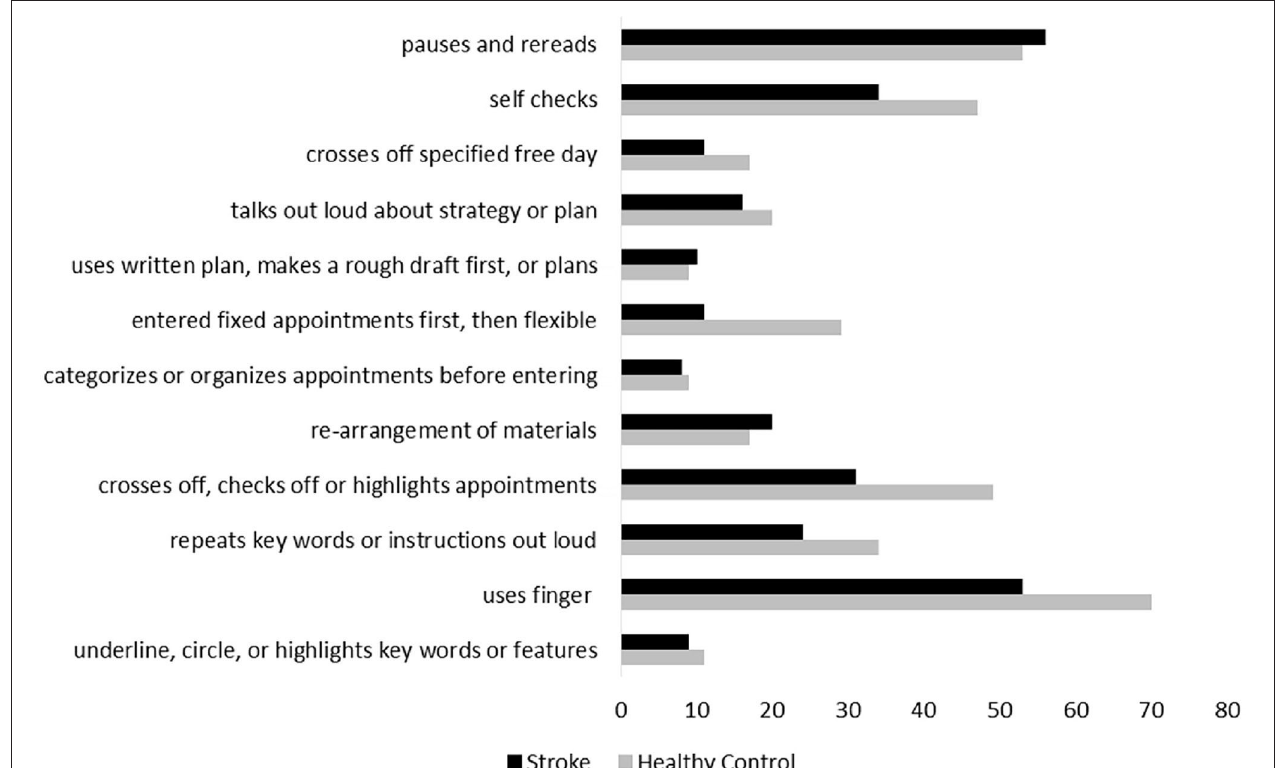
FIGURE 2 | Frequency of strategies used by stroke patients and healthy control participants.